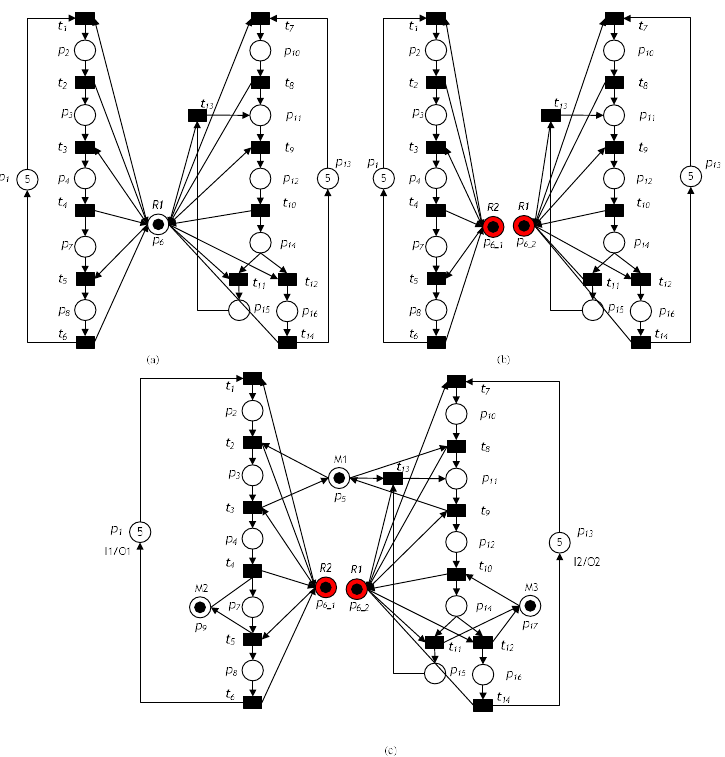
Figure 6. A reconfigured S 3 PR net by addition of a new robot. ( a ) Left hand side net L . ( b ) Right hand side net R . ( c ) A reconfigurable S 3 PR net ( N 4 , M 4o ).